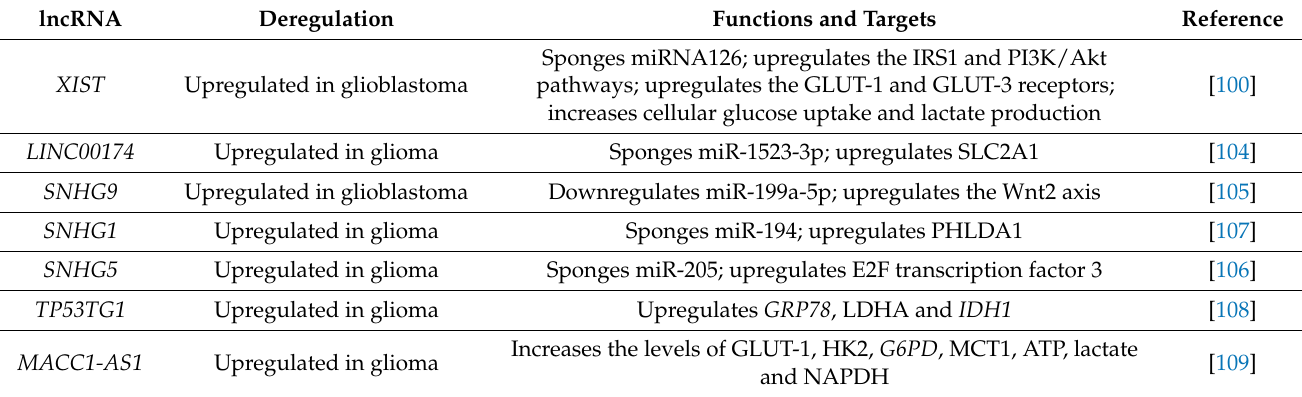
Table 6. Examples of lncRNAs implicated in glucose metabolism alteration in brain